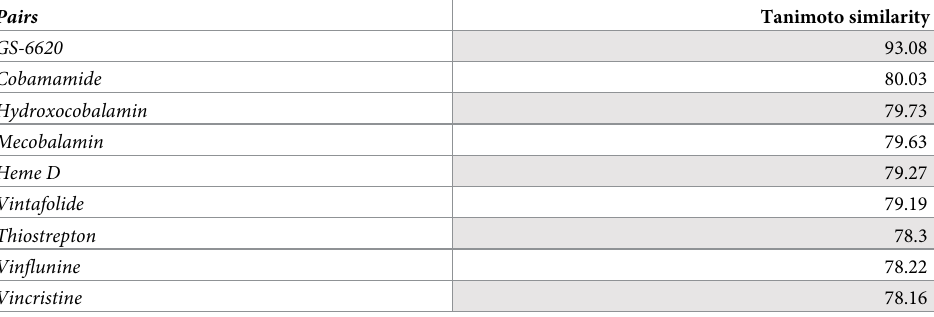
Table 6. Top 10 molecules with similarity to Remdesivir according to the Tanimoto